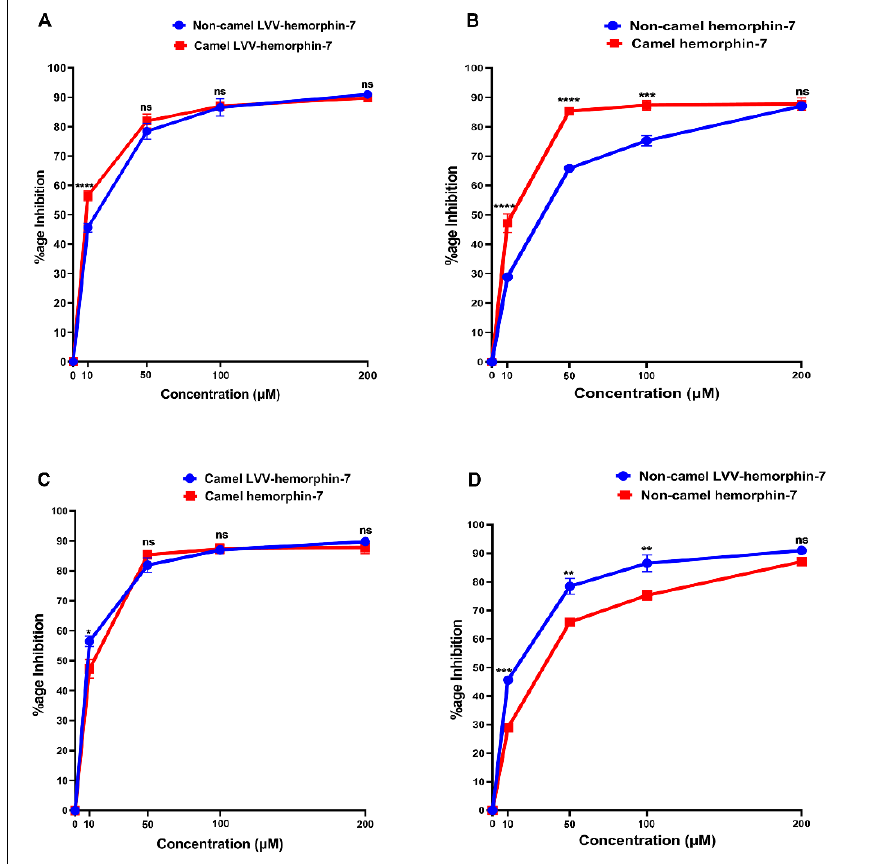
Figure 6. Dose-response curves of camel and non-camel hemorphins. ACE inhibition is shown in percentage for each dose. ( A ) Comparison of camel and non-camel LVV-hemorphin-7; ( B ) Comparison of camel and non-camel hemorphin-7; ( C ) Comparison of camel LVV-hemorphin-7 and hemorphin-7; ( D ) Comparison of non-camel LVV-hemorphin-7 and hemorphin-7. The comparison of different doses was done using two-way ANOVA and Sidak’s multiple-comparisons test to measure statistical significance between different hemorphins. Data are represented as mean ± SEM of three independent experiments. **** p < 0.0001 , *** p < 0.001 , ** p < 0.01 , * p < 0.05 and ns p > 0.05 .